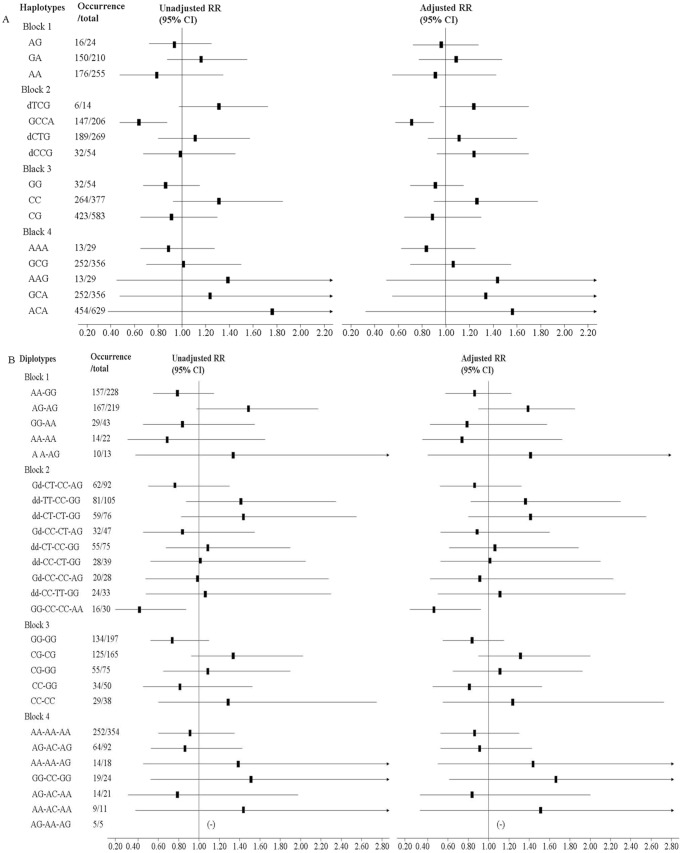
Association of (A) haplotypes and (B) diplotypes on 9q33.3 with risk of hepatic fibrosis in chronic S. japonicum infected Adults in the discovery study.Block 1, rs12343206–rs10733669; Block 2, rs11355458–rs17840761–rs17840762–rs391957; Block 3, rs10819146–rs531599; Block 4, rs2454217–rs487914–rs488039. RR, relative risk; CI, confidence interval. Unadjusted RR was calculated using Pearson Chi-square test. Adjusted RR was adjusted for age, gender, smoking, drinking and HBsAg. d, the deleted base.